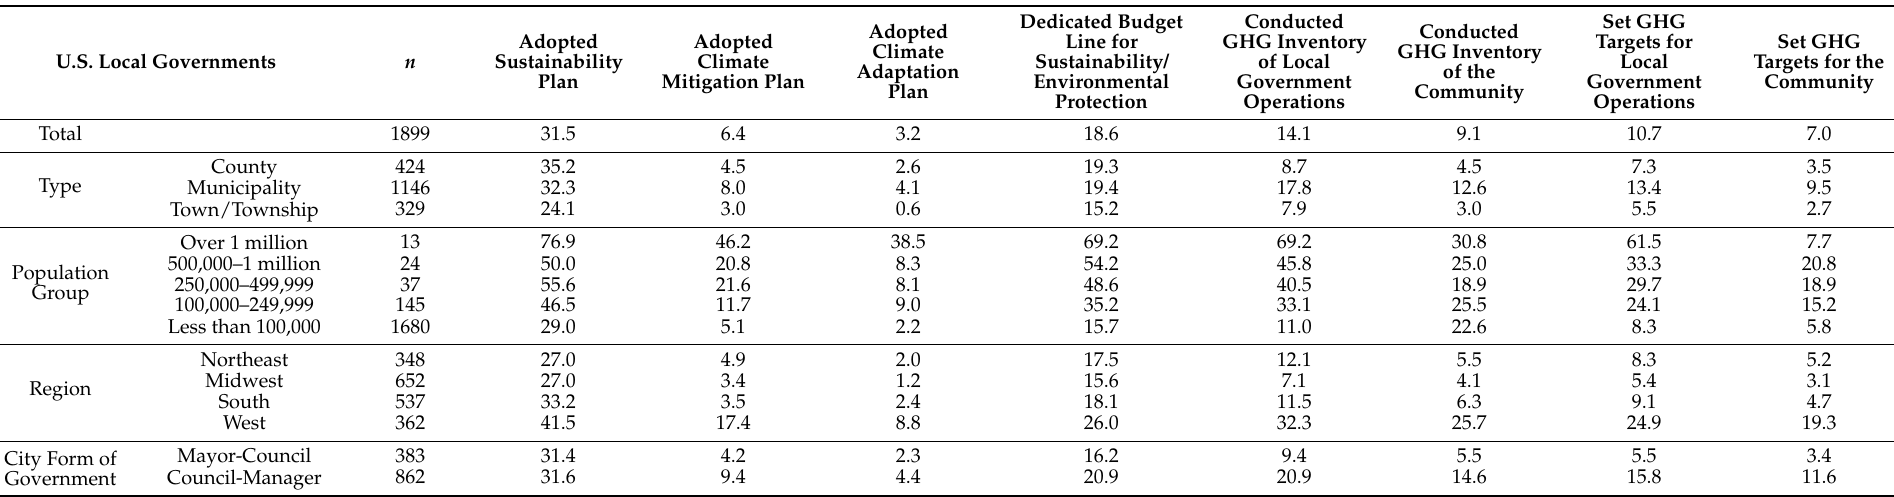
Table 4. U.S. Local Government Sustainability Practices. Percent responding yes. Source: International City/County Management Association, Local Government Sustainability Practices Survey